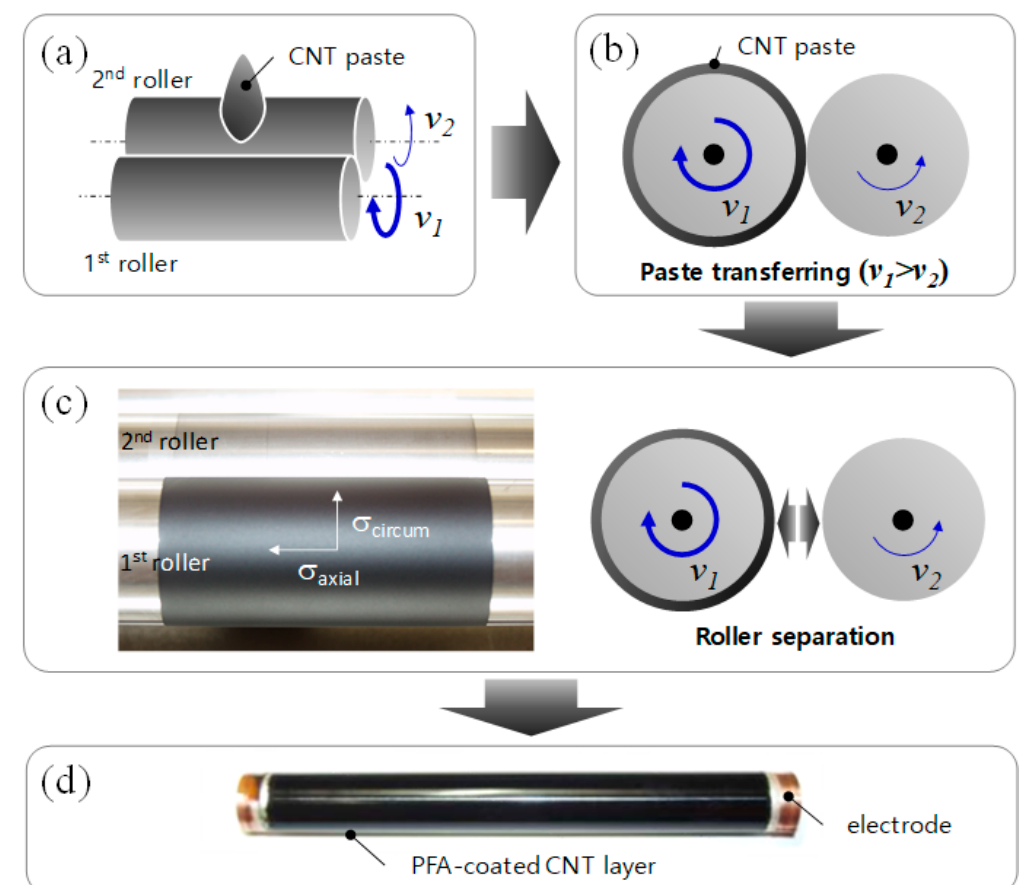
Figure 2. Circumferential shearing process for uniform coating on a cylindrical polyimide (PI) tube. ( a ) MWNT paste feeding, ( b ) paste transferring on a roller with a higher speed, ( c ) roller separation, and ( d ) MWNT heating element with a perfluoroalkoxy alkanes (PFA) layer and electrodes.